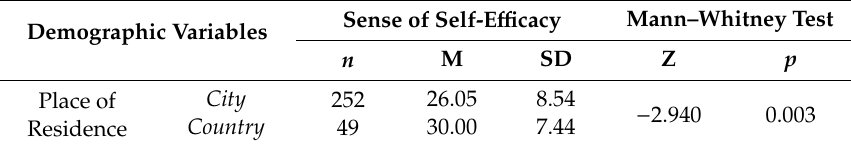
Table 4. Place of residence and the level of self-e ffi cacy in the respondents. Demographic Variables